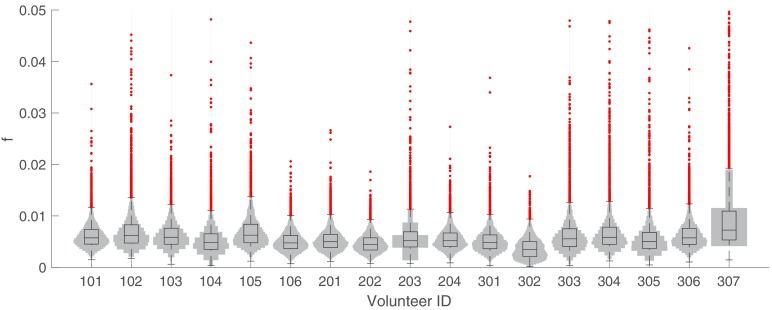
The marginal posterior distributions of the individual parameter of f (sexual commitment rate; not converted to percentage) for all 17 volunteers.The violin plots (gray area) show the distributions of 5000 posterior samples. Box plots show the 25%, 50% (median) and 75% quantiles with outliers indicated by red dots. Relevant details of the individual parameter are provided in the Materials and methods in the main text.